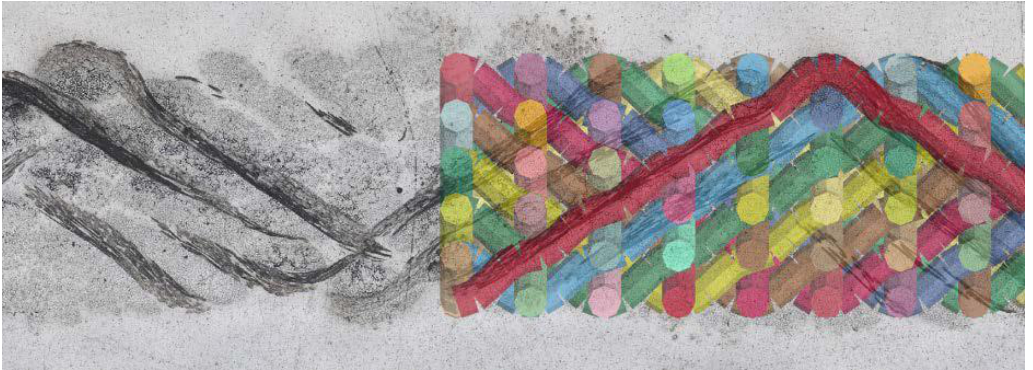
Figure 8. Comparison of a model and micrograph of the corresponding fabric (angle-through-thickness).